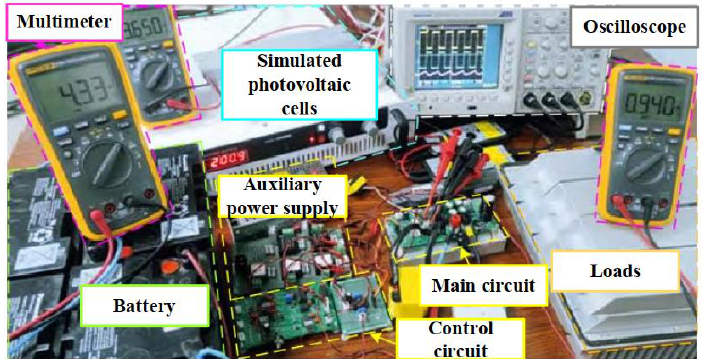
Figure 9. Hardware for the experiment platform.